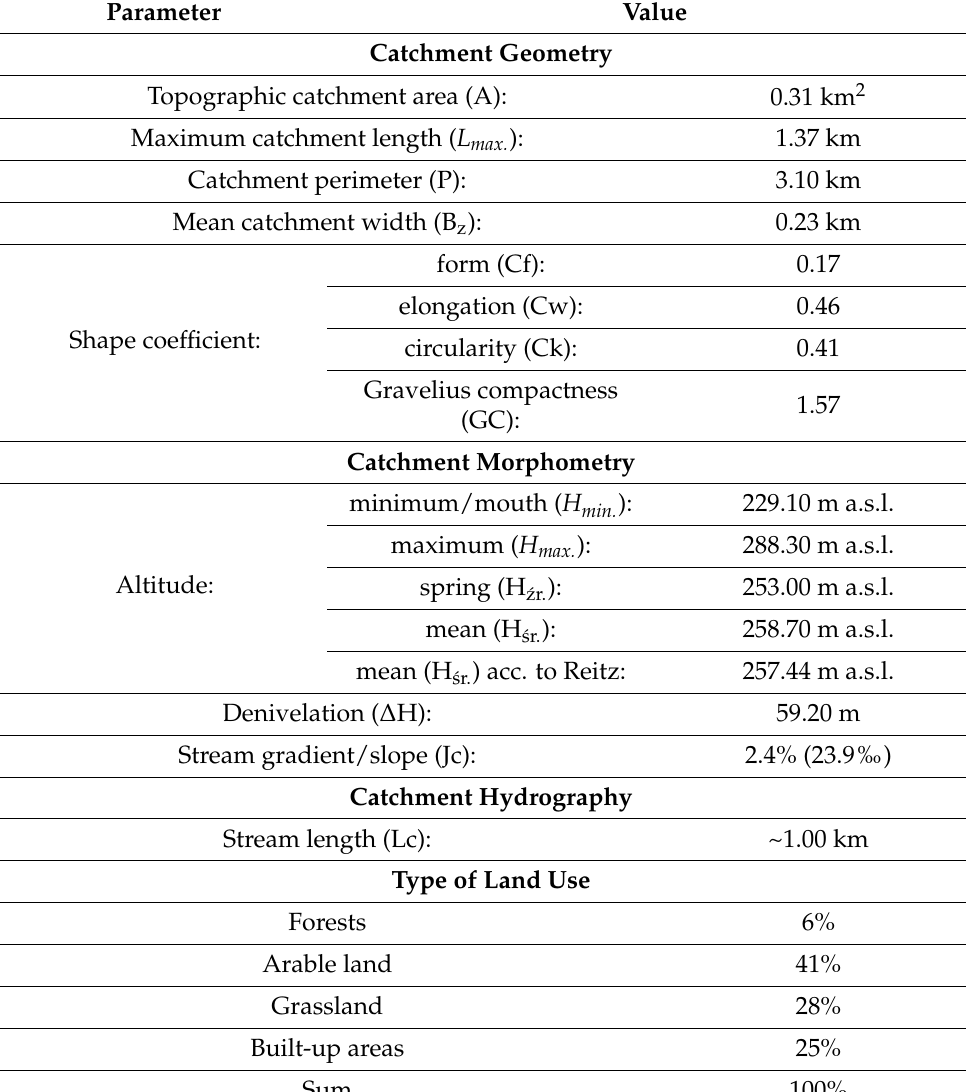
Table 3. Physiographic parameters of the studies stream